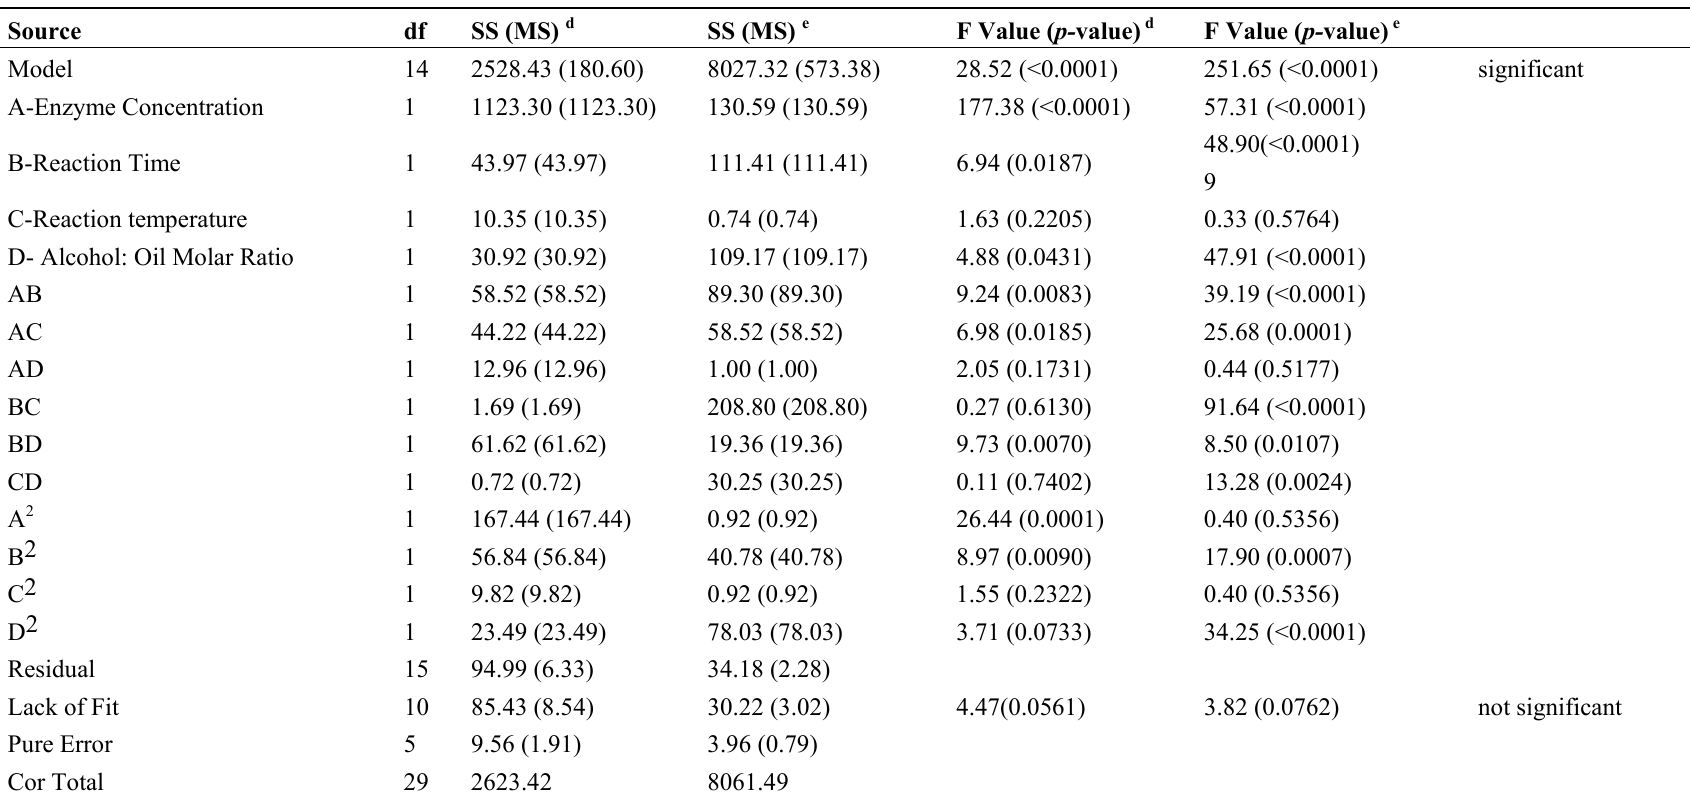
Table 4. Response surface quadratic model analysis of variance (ANOVA) table for enzymatic transesterification of rice bran oil.